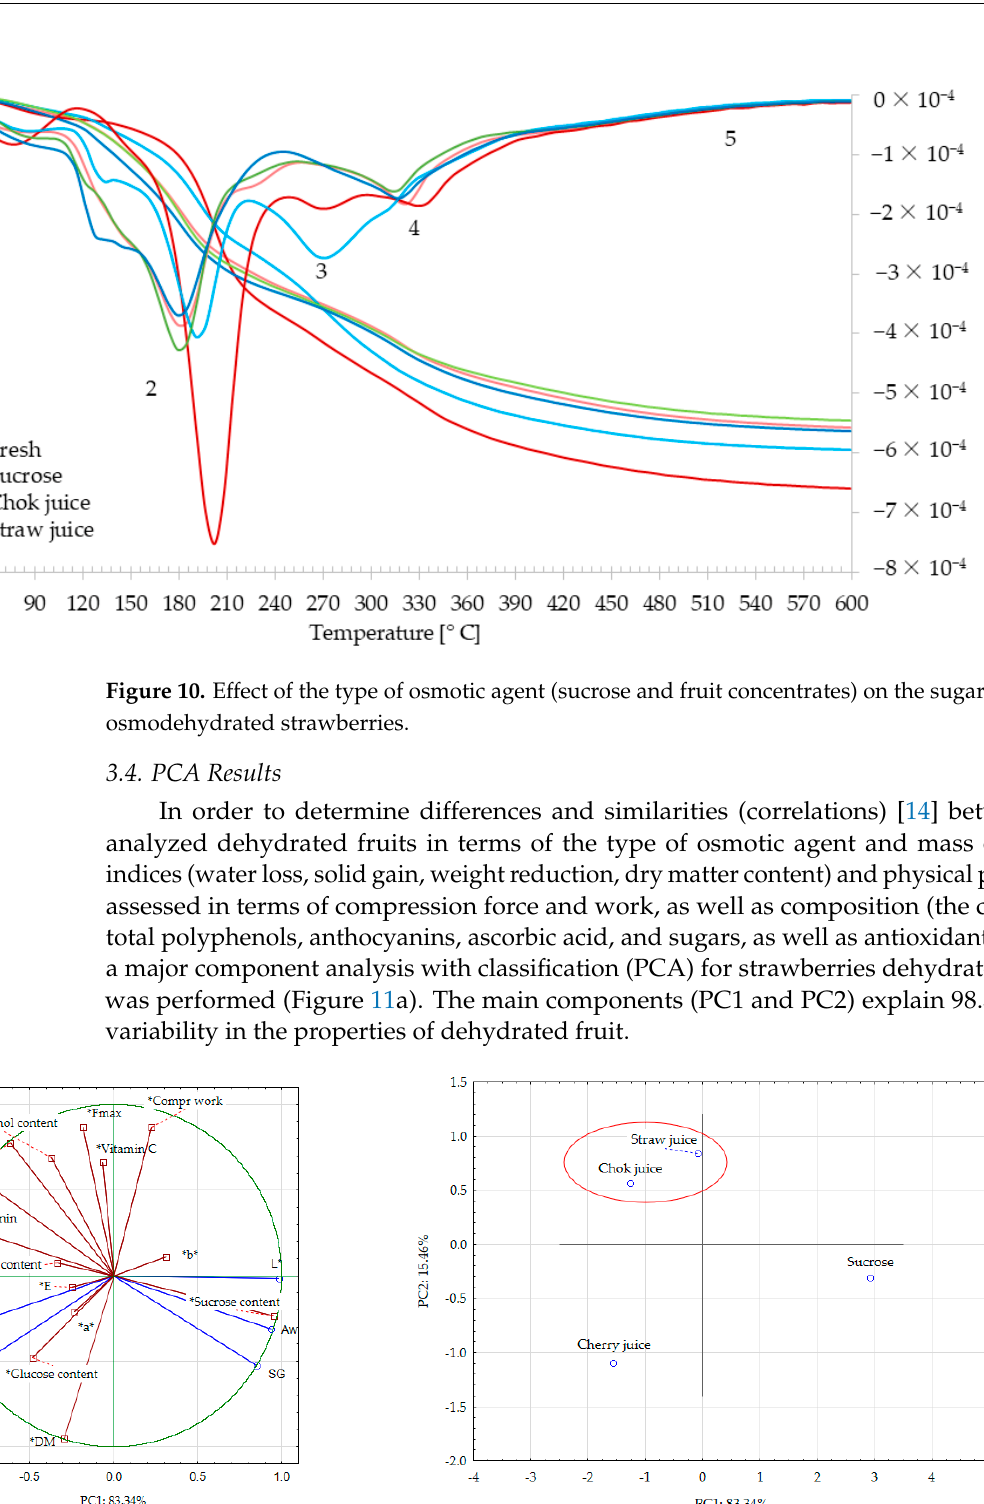
Figure 9. Effect of the type of osmotic agent (sucrose and fruit concentrates) on the sugar content of osmodehydrated strawberries. Different letters above columns show the statistical difference ( p < 0.05).